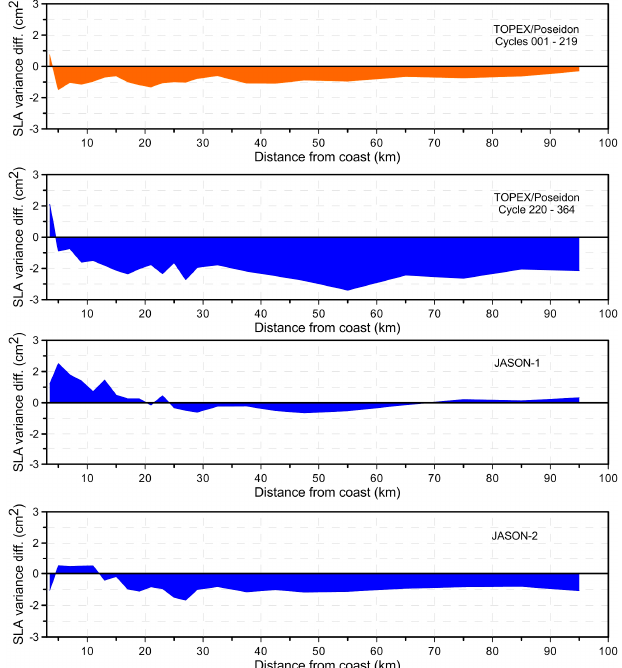
Figure 9. SLA variance differences (cm 2 ) function of the distance from the coast; top to bottom : between the smoothed dual-frequency and NIC2009 (orange) for TOPEX/Poseidon cycles 1–219 and between the smoothed dual-frequency and JPL GIM (blue) for TOPEX/Poseidon cycles 220 to 364, Jason-1 cycles 1 to 259 and Jason-2 cycles 1 to 280. Remote Sens. 2017 , 9 , 102